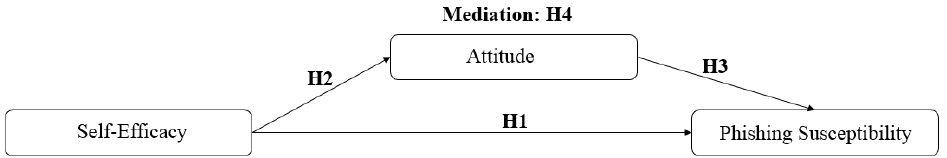
Figure 1. Research